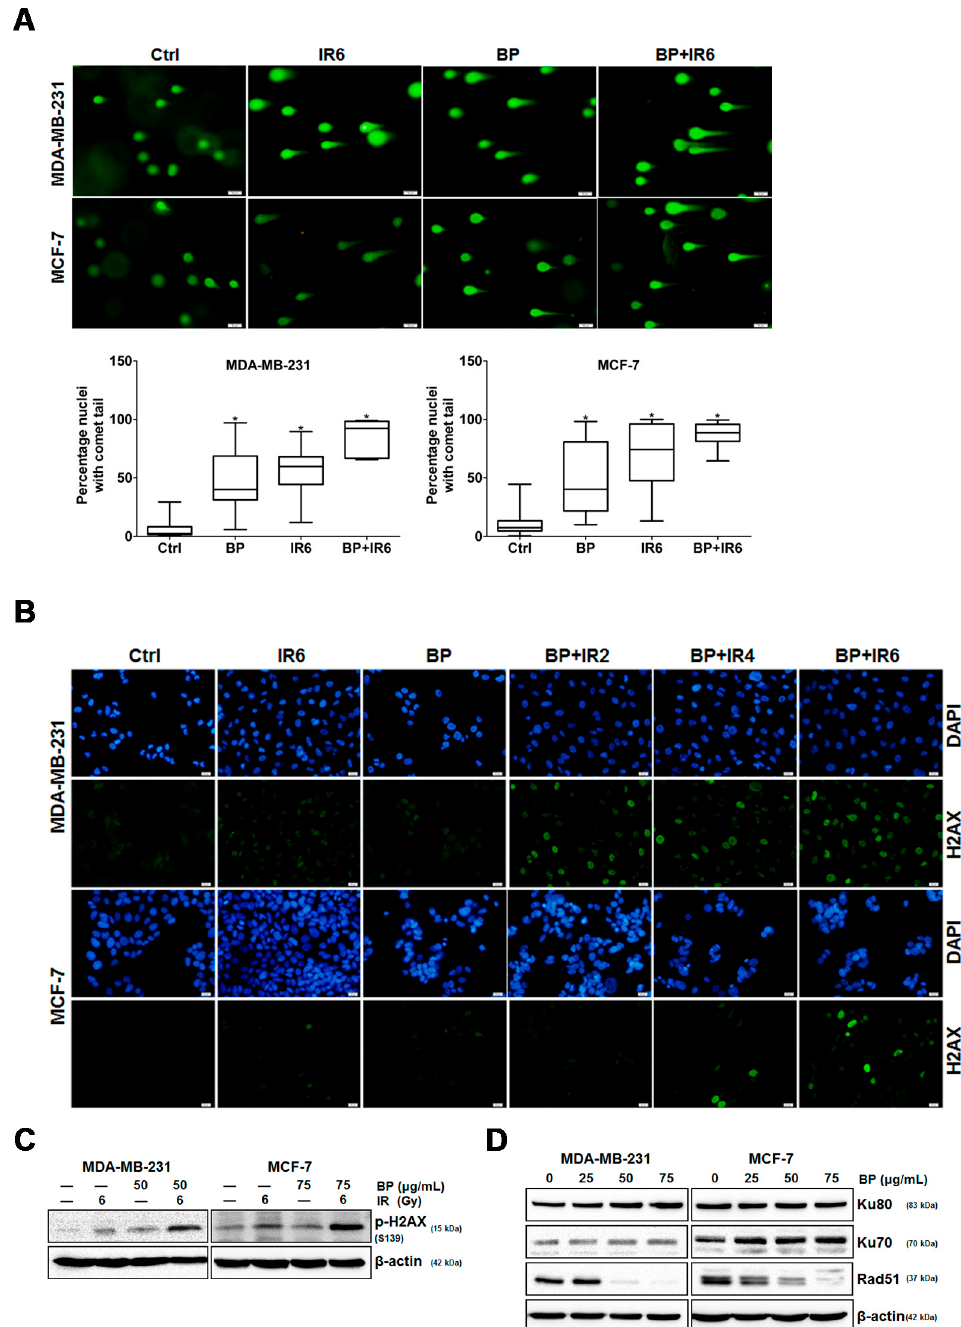
Figure 5. DNA damage induced by BP and/or IR treatment in human breast cancer cells. ( A ) Human breast cancer cells were treated in the presence or absence of BP for 24 h and then exposed with or without IR (6 Gy). After 48 h, the cells were harvested and the comet assay performed. The percentage of DNA in the tail was plotted as determined by OpenComet. The values are the mean ± S.D. from three independent experiments, * p < 0.05 vs. vehicle; ( B ) Human breast cancer cells were treated in the presence or absence of BP for 24 h, exposed with IR (2, 4 or 6 Gy), and then fixed for immunofluorescence analysis of the γ -H2AX foci. Nuclear staining was done with DAPI (blue) while γ -H2AX staining appeared green; ( C ) The cells were pre-treated in the presence or absence of BP for 24 h and then exposed with or without IR (6 Gy). The cell lysates were harvested and analyzed for p-H2AX (ser139) by western blot; ( D ) Human breast cancer cells were treated with 25, 50 and 75 μ g/mL BP for 48 h, and western blot analysis was performed for Ku80, Ku70, and Rad51.